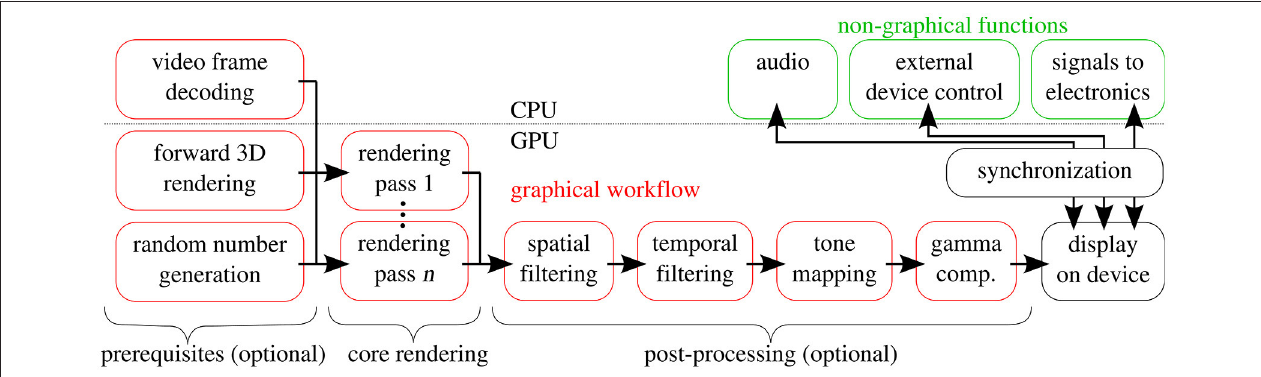
FIGURE 4 | Generation procedure of a single stimulus frame. Prerequisites, core rendering and post processing phases are each composed of passes marked by red